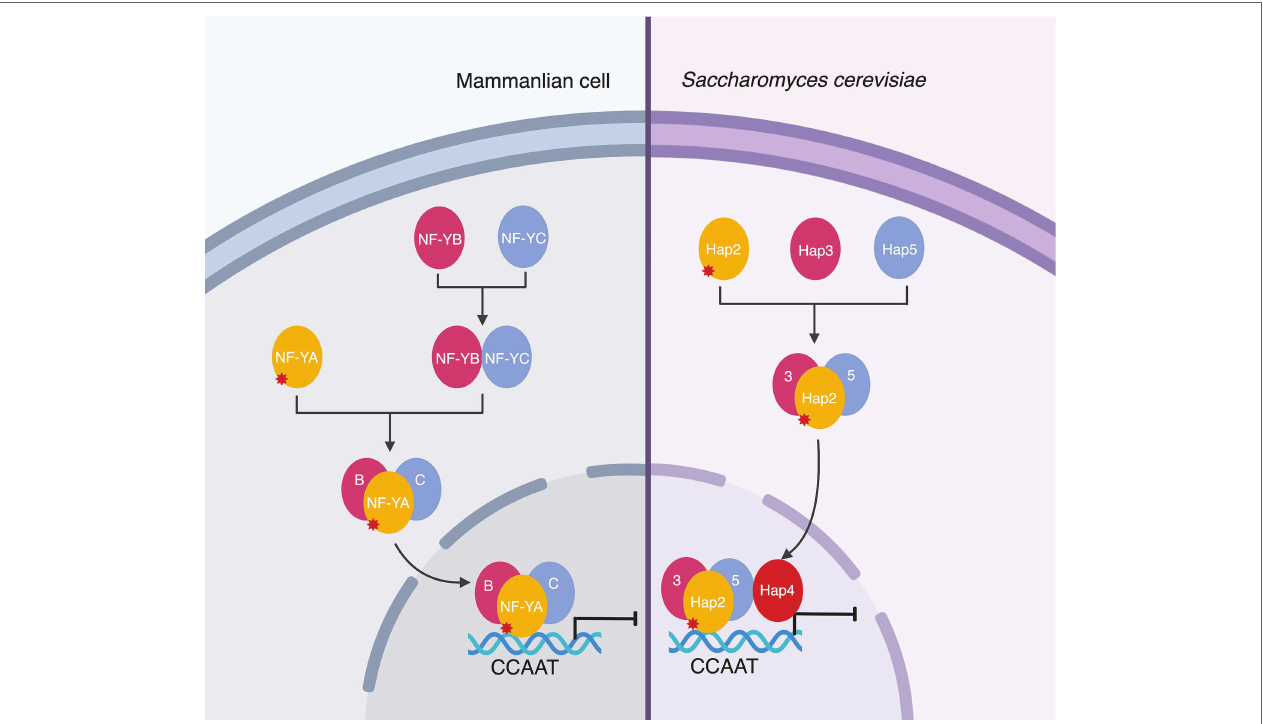
FIGURE 1 | Comparison of the assembly mode of the Hap complex between yeast and mammalian cells. The symbol marked in red asterisk represents the